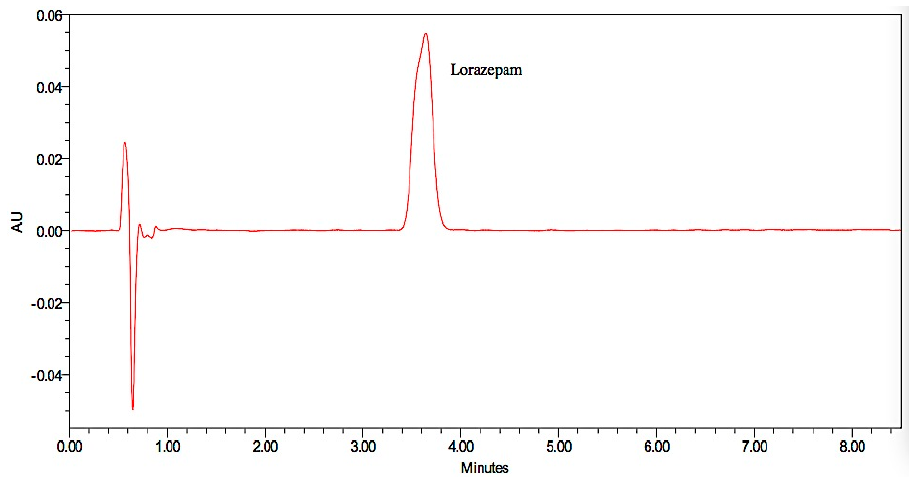
Figure 6. Representative chromatograms of the lorazepam drug sample.